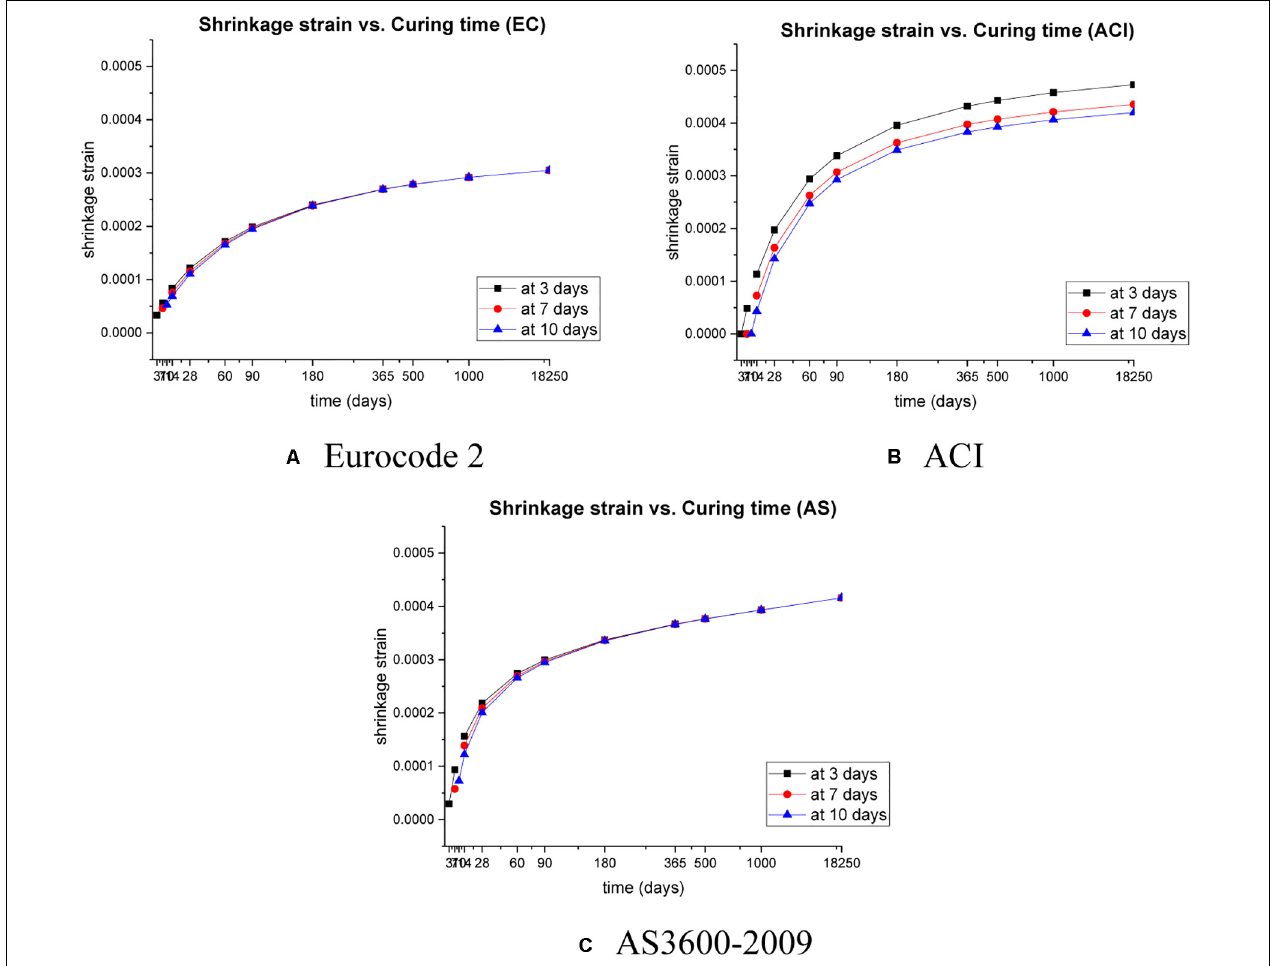
FIGURE 7 | Curing time–shrinkage relationship. (A) Euro Code 2, (B) ACI and (C) AS3600-2009.